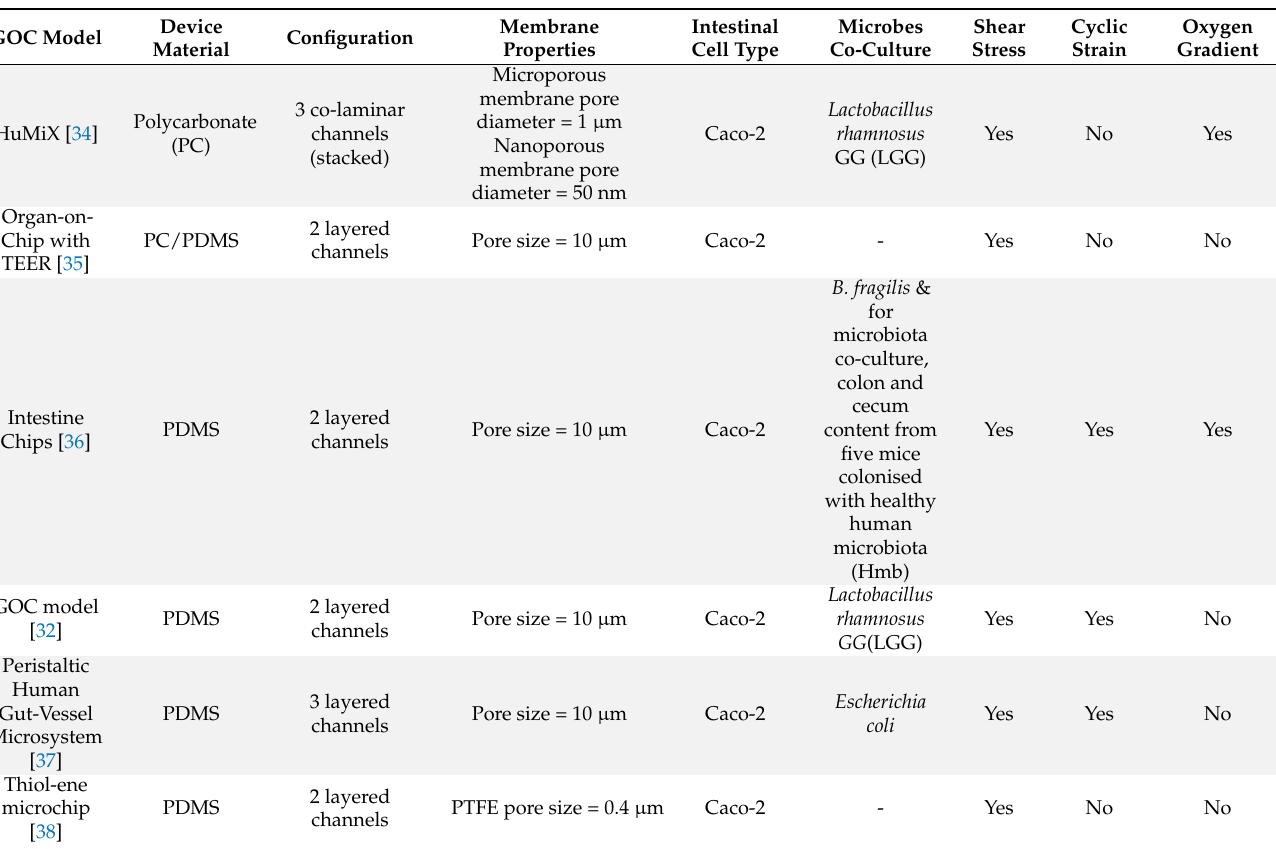
Table 1. Summary of technological approaches and characteristics of representative GOC